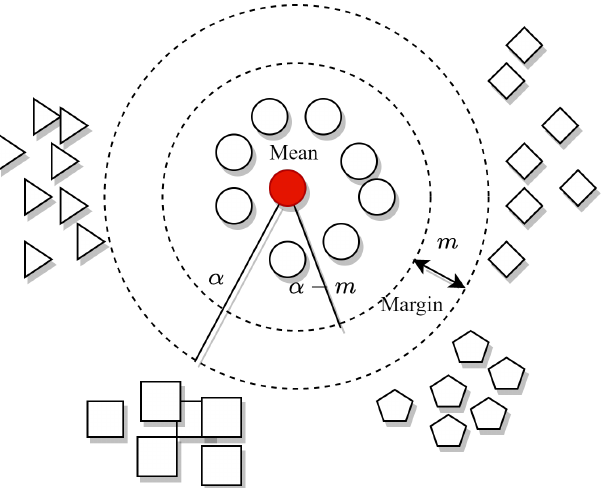
Figure 2. Illustration of interclass loss.